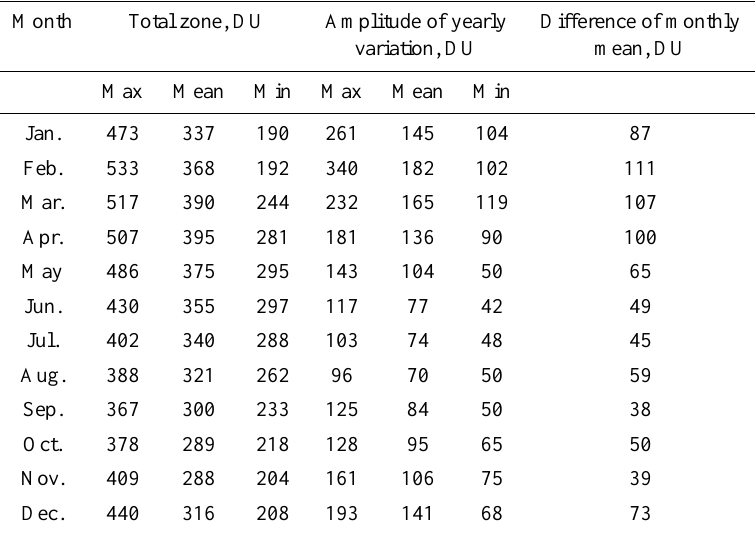
Month Total zone, DU Amplitude of yearly Difference of monthly variation, DU mean, DU Max Mean Min Max Mean Min